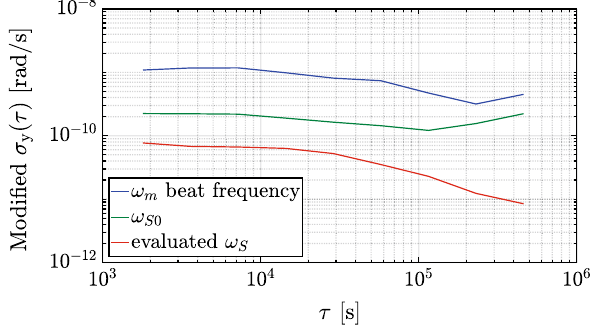
Fig. 6 The first step of the analysis evaluates ω s 0 , which accounts for back-scatter noise; ω ξ has been developed to further improve back- scatter cancellation, taking into account inaccuracies in the signals pro- duced by photodiodes PH 1, PH 2, their demodulated intensity I S 1 , 2 and dephasing (cid:9)